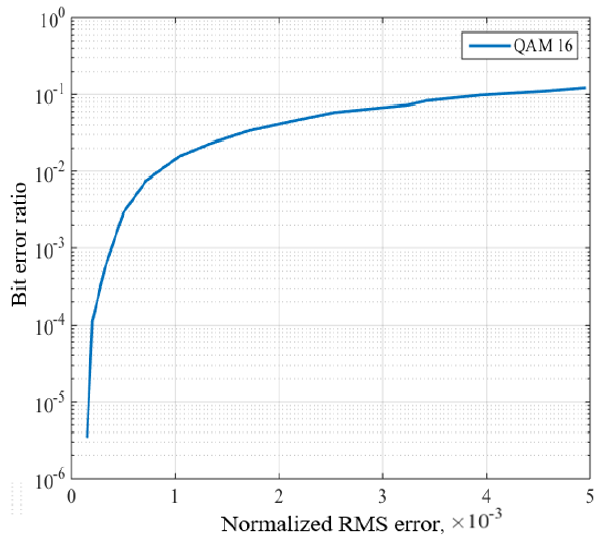
Fig. 5. Dependence of the probability of bit error on the normalized RMS error of the estimate of the transfer function.